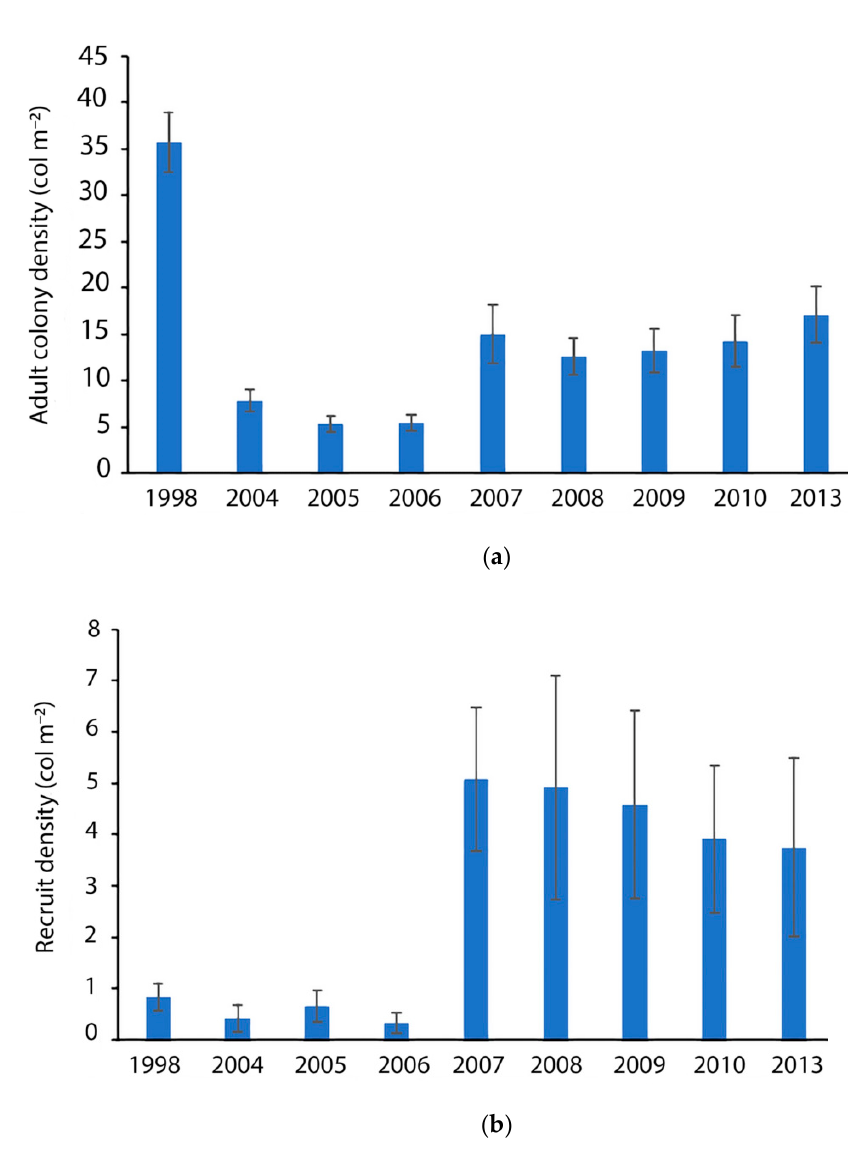
Figure 3. ( a ) Adult colony density and ( b ) recruit density during the observational period.